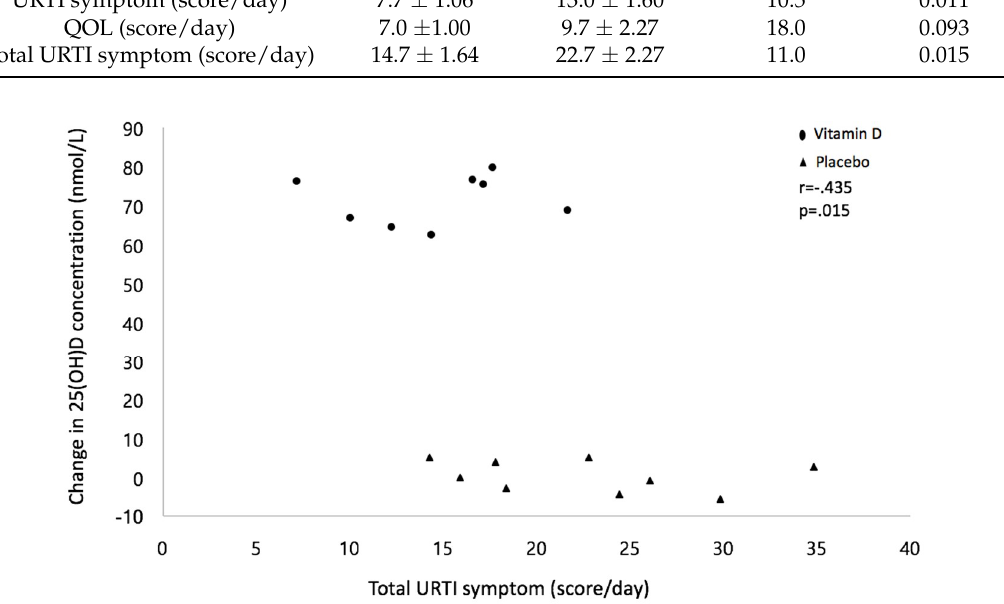
Figure 4. Correlation between the change in 25(OH)D concentration and total URTI symptom. Note: number of missing data from the vitamin D group was five while the placebo group was three; the correlations within each group were not significant (Vitamin D group, r = 0.143, p = 0.621, Placebo group, r = −0.366, p = 0.173, respectively).